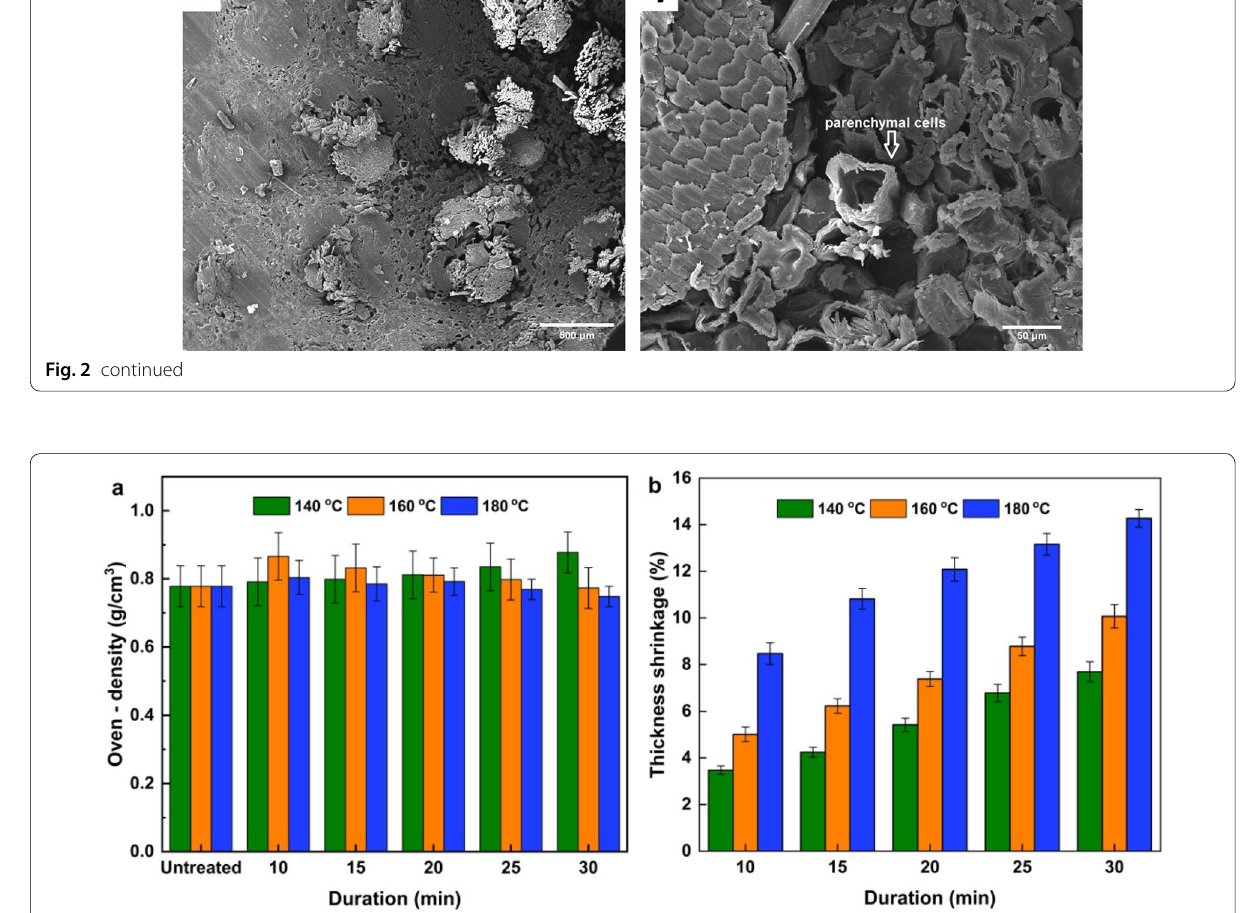
Fig. 3 Oven-dried density and thickness shrinkage of bamboo culms